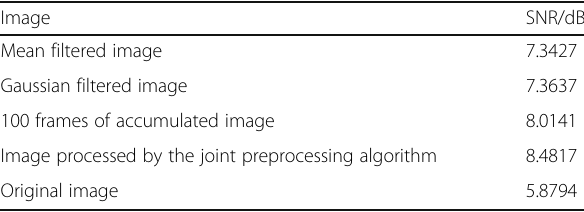
Table 1 The SNRs of original single-channel grayscale image and single-channel image processed by each preprocessing method